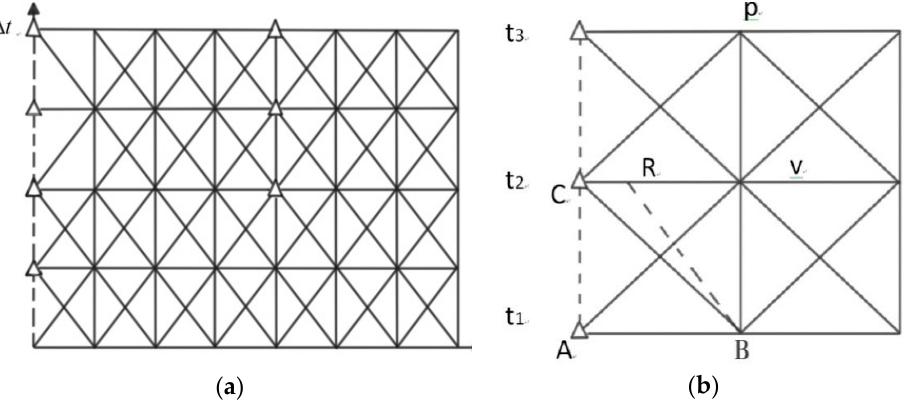
Figure 1. Method of the floating grid: ( a ) fixed grid method; ( b ) floating grid method.